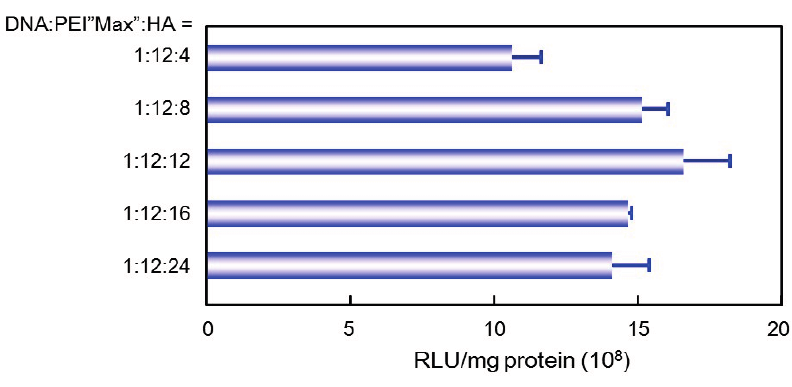
Figure 5. Effect of mixing ratio of hyaluronic acid on the gene expression activity.